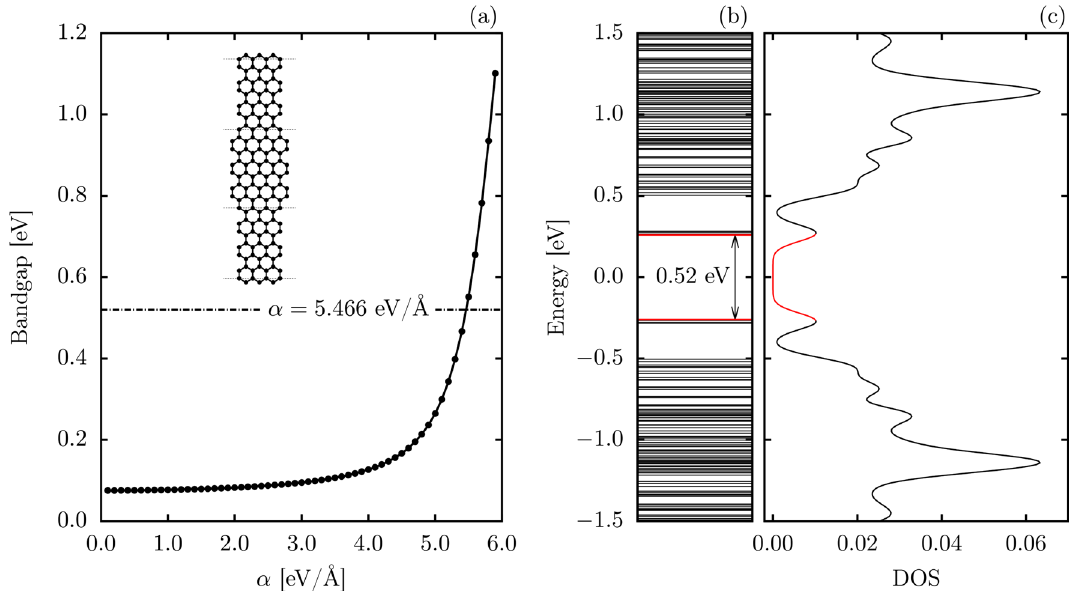
Figure 1. ( a ) Bandgap as a function of the electron-phonon coupling for the 7,9-GNR. The internal panel presents a schematic representation of the studied structure, ( b ) energy levels, and ( c ) density of states for the 7,9-AGNR with α = 5.466